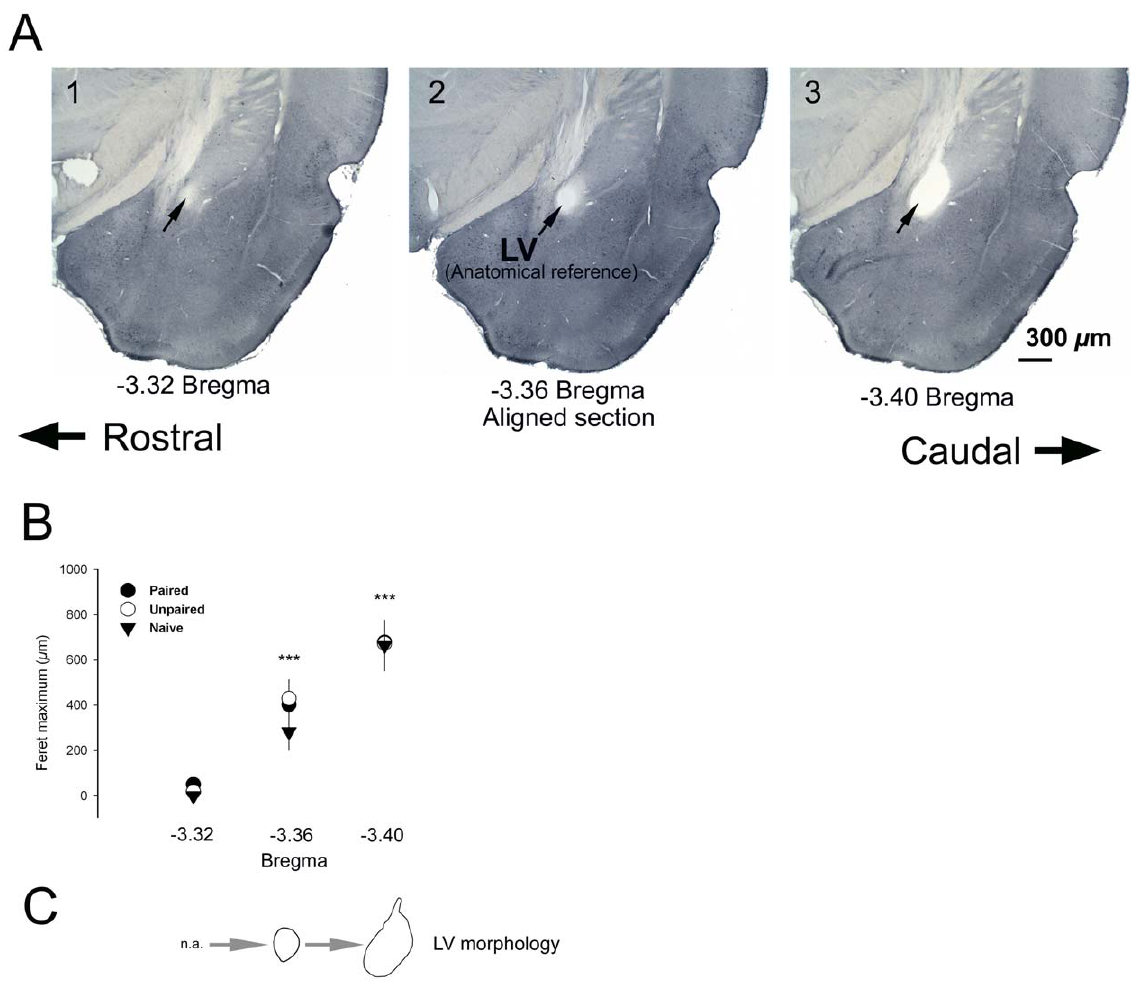
Figure 1. The entrance of the lateral ventricle was used as an anatomical landmark for section alignment. (A) Representative photomicrographs (2x magnification) of three consecutive 40 m m sections depicting (1) the ‘‘blind pouch’’ (indicated by arrowhead) rostral to the initial opening of the lateral ventricle (LV), (2) initial opening of the LV (Bregma 2 3.36) and (3) the LV (indicated by arrowhead) caudal to the initial opening of the LV (B) The maximum feret measurement of the LV was significantly different at the section rostral (Bregma 2 3.32) and caudal (Bregma 2 3.40) to the section chosen for mapping (Bregma 2 3.36). (C) Representative reconstructions of the morphology of the LV at Bregma 2 3.32, 2 3.36 and 2 3.40. The reconstructions of the LV for consecutive sections are representative of the mean maximum feret distance for all subjects. Circles represent the mean LV feret measurement 6 standard error of the mean. *** indicates p , .00001.